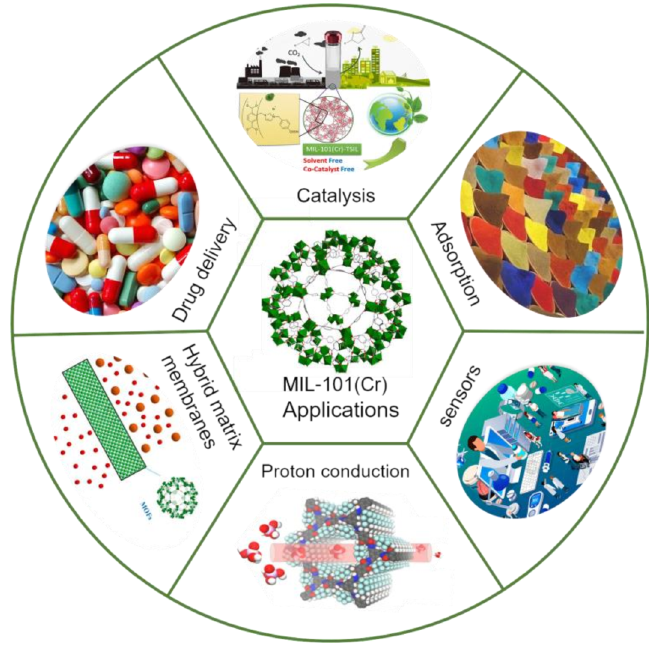
Figure 7. The universal application of